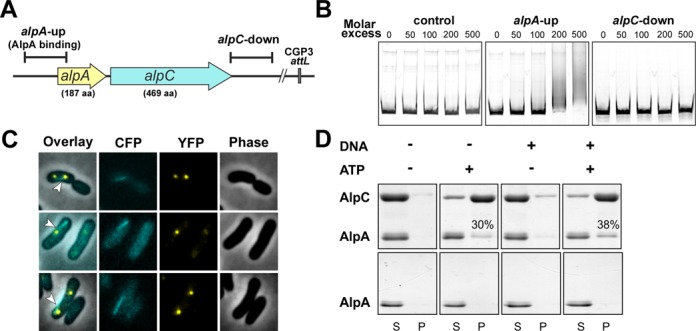
Characterization of the putative adaptor protein AlpA (cg1891) (A) Genomic localization of the AlpA binding region. The DNA fragment tested for AlpA-binding is located upstream of alpA; 110 bp downstream of the transcriptional start site of alpA. (B) EMSA studies of AlpA with potential DNA target regions. For DNA–protein interaction studies, DNA fragments (500 bp) of the up- and downstream region of the putative operon alpA–alpC were incubated with different molar ratios of AlpA (0-, 200- and 500-fold molar excess of AlpA). The promoter region of cg2036 served as control. (C) Co-visualization studies of eCFP-AlpC and AlpA-eYFP. The expression of both proteins was induced with mitomycin C for 2 h prior to localization analysis (D) AlpA interacts with AlpC in vitro. Purified AlpA and AlpC were incubated with ATP, DNA or both ATP and DNA. The supernatant and pellet fractions were separated by centrifugation. Both fractions were analyzed by SDS-PAGE and visualized by Coomassie staining. In the absence of AlpC, AlpA does not sediment, irrespective of the presence of ATP and/or DNA (lower panel). AlpA co-sedimentes with AlpC in the presence of ATP (30%) or ATP and DNA (38%). S, supernatant; P, pellet. The amount of sedimented AlpA protein was quantified by using ImageQuant TL software (GE Healthcare).